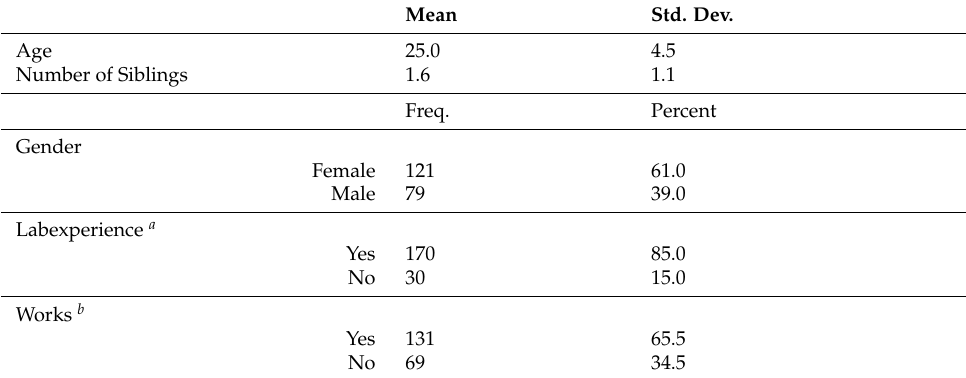
Table A1. Breakdown of the